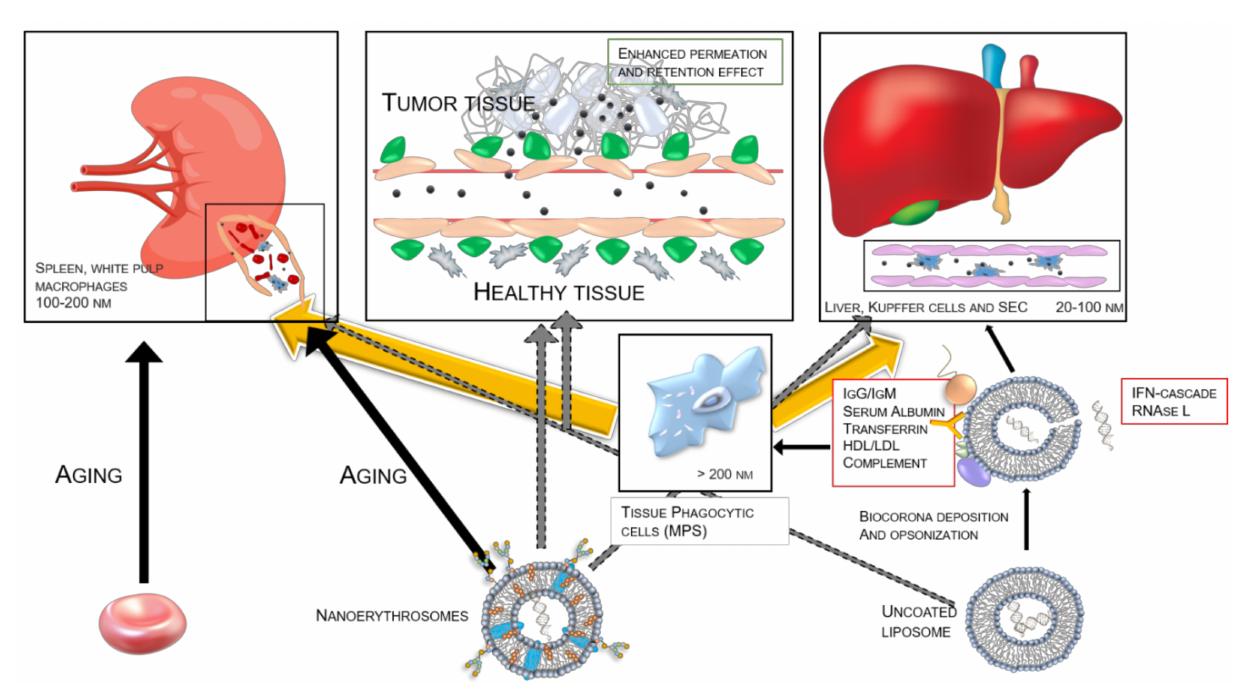
Figure 3. Main clearance pathways of erythrocytes, nano-erythrosomes and uncoated liposomes (i.e., without PEGylation). Solid black arrows represent the majority fate of the nanoparticles. In yellow arrows, the rapid and unescapable clearance exerted by spleen and liver on nanoparticle after mononuclear phagocyte system recognition. Dashed arrows show the minority clearance pathways. In the interaction with mononuclear phagocyte system, there is a strong dependence on the opsonization of nanoparticles, by antibodies, serum albumin, etc. If the nanoparticle is loaded with dsRNA, the sensing of such a presence elicits the activation of interferone-tyrosin kinase cascade [4] and RNAse L activity. Then, the liposome is degraded by the liver. In the case of nano-erythrosomes, the supposed clearance pathways partially superimpose on the liposomes. However, being recognized as self, they are not be prone to MPS interaction. The most wanted localization of a nanoparticle in cancer therapy is in tumor tissues. Nanoparticles have to be small enough to take advantage of the EPR effect [27] Lastly, the natural process of aging in erythrocytes leads to their degradation in the spleen. The spleen model can be retrieved here (bit.ly/3uMnhsl) e for